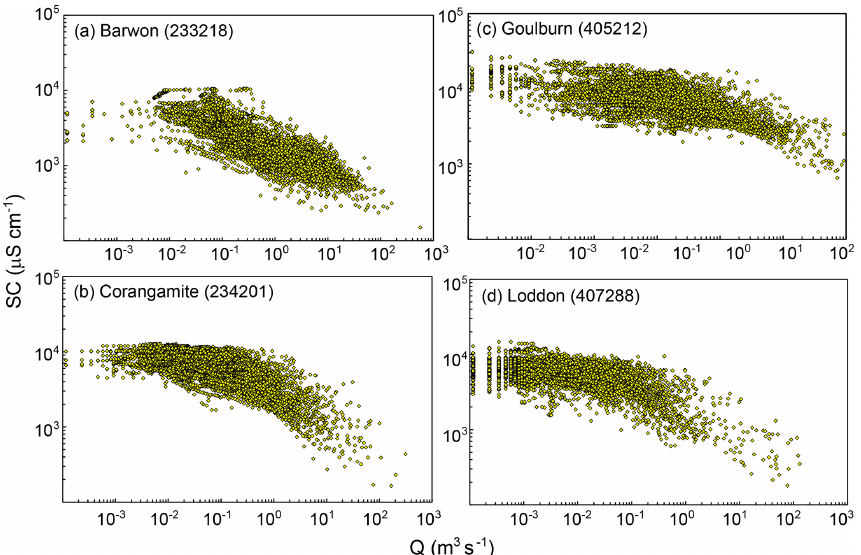
Figure 3. Variation in streamflow ( Q ) and river SC for one station in the Barwon (a) , Corangamite (b) , Goulburn (c) , and Loddon (d) catchments (data from the Department of Environment, Land, Water and Planning,